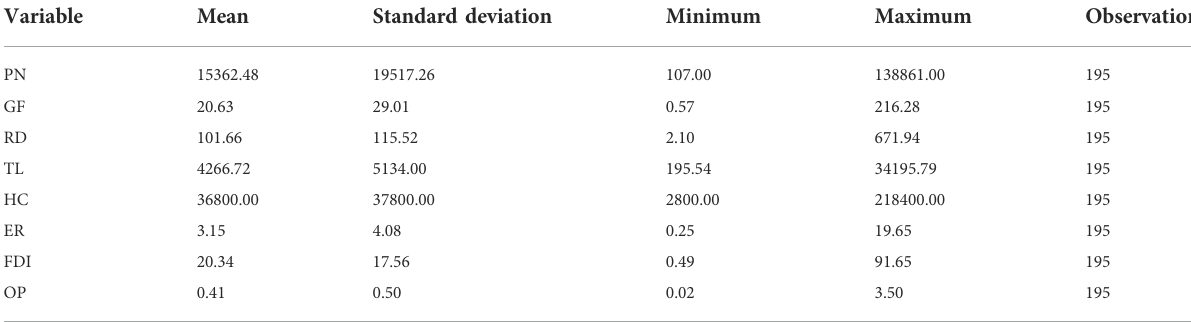
TABLE 2 Descriptive statistical analysis of each variable.